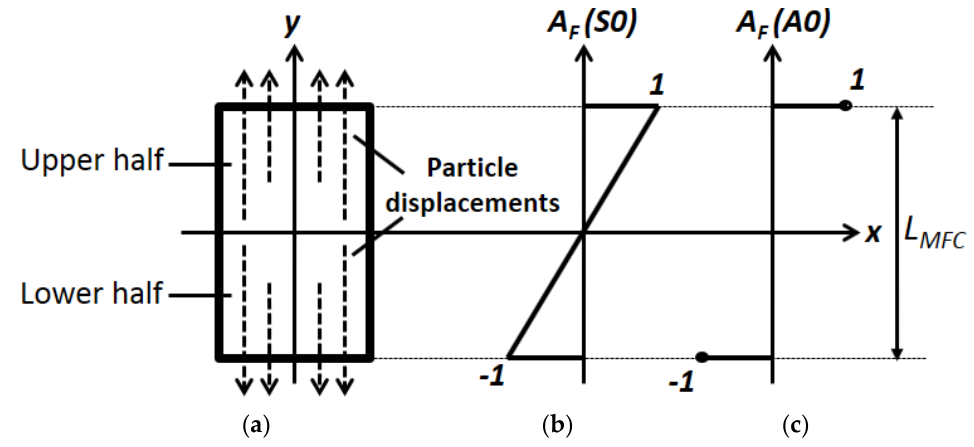
Figure 2. Particle displacements in P1-type MFC (28 × 14 mm) along with its length ( a ) and the amplitude correction factor ( A F ) by previously developed model for the S0 ( b ) and the A0 mode ( c ).